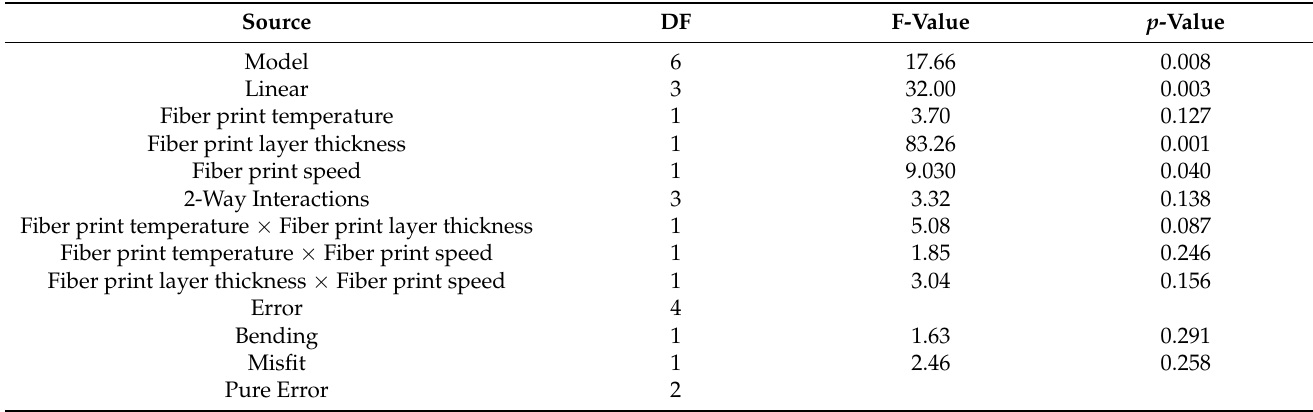
Table 5. Analysis of